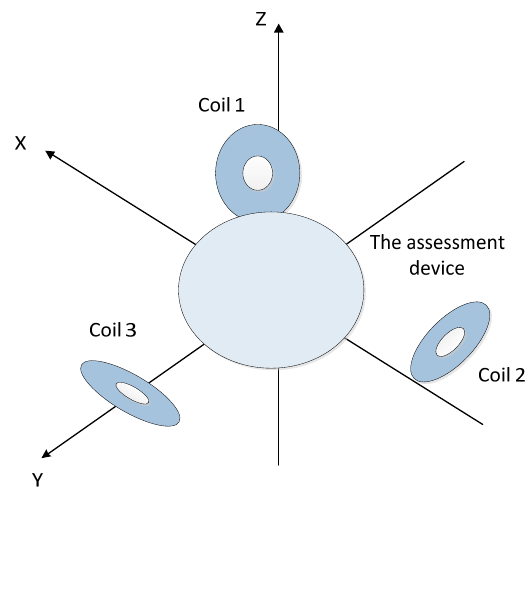
Figure 10. The second layout style of the experimental equipment.